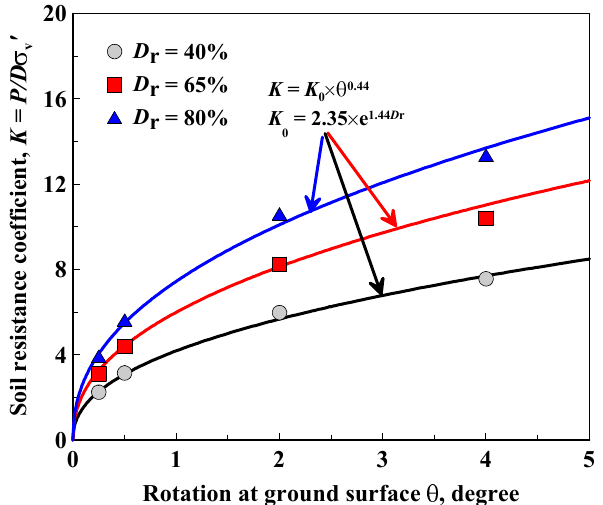
Figure 22. Soil resistance coefficient K of sands with different relative densities for different deflection criteria.